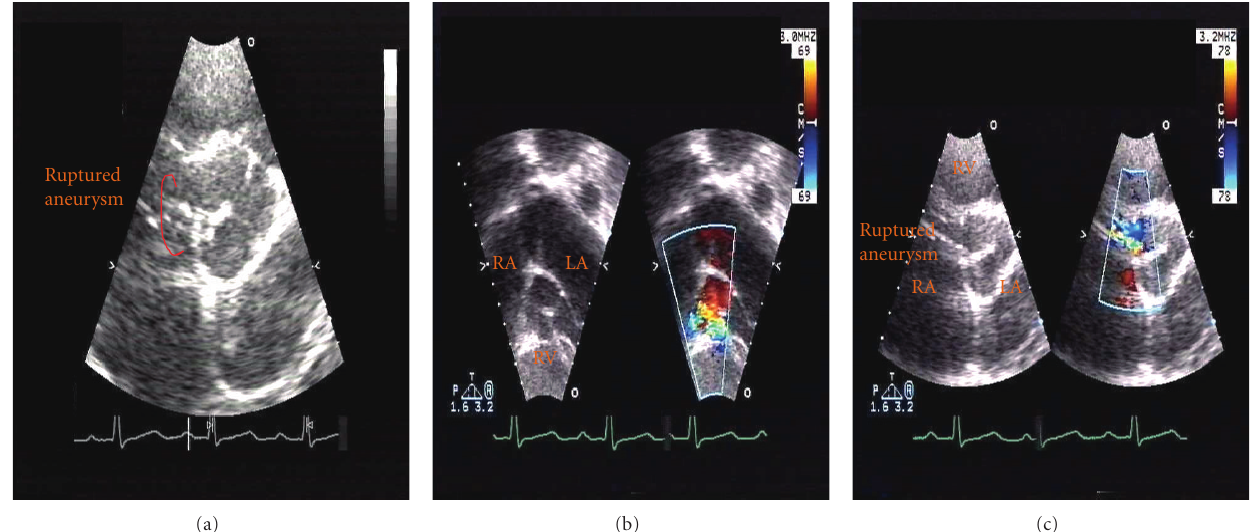
Figure 2: (a) short-axis echo view. Demonstrating fingerlike protrusion evident of ruptured right coronary sinus of Valsalva aneurysm. (b) Subcostal view. (c) Short-axis view of color compared with color flow doppler evidence of aorta to right ventricle fistulous connection.